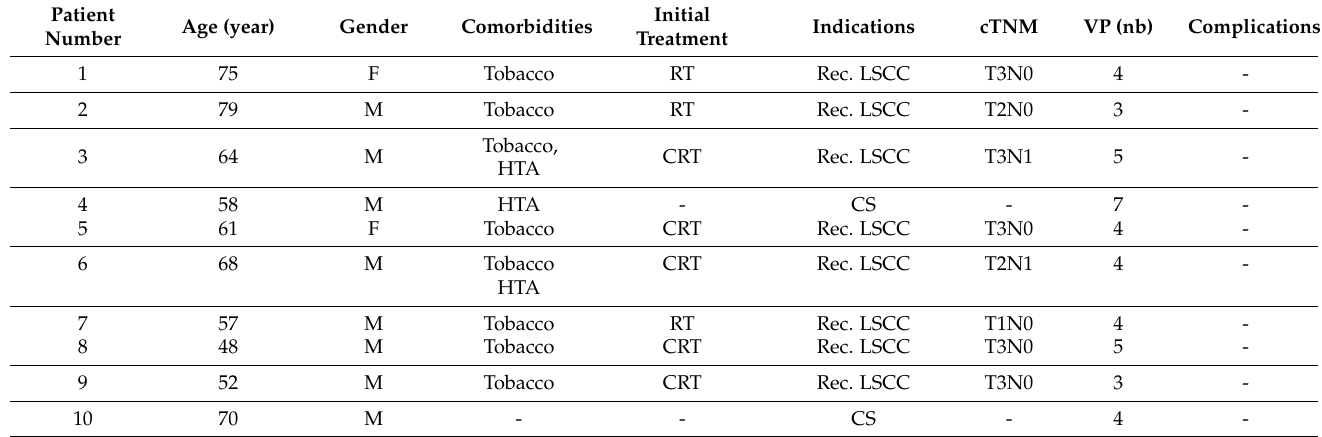
Table 1. Characteristics of patients followed by the speech